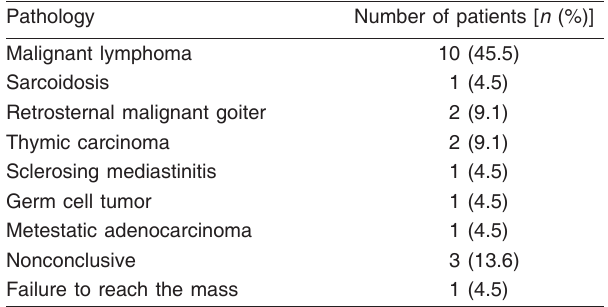
Table 4 Histopathological results